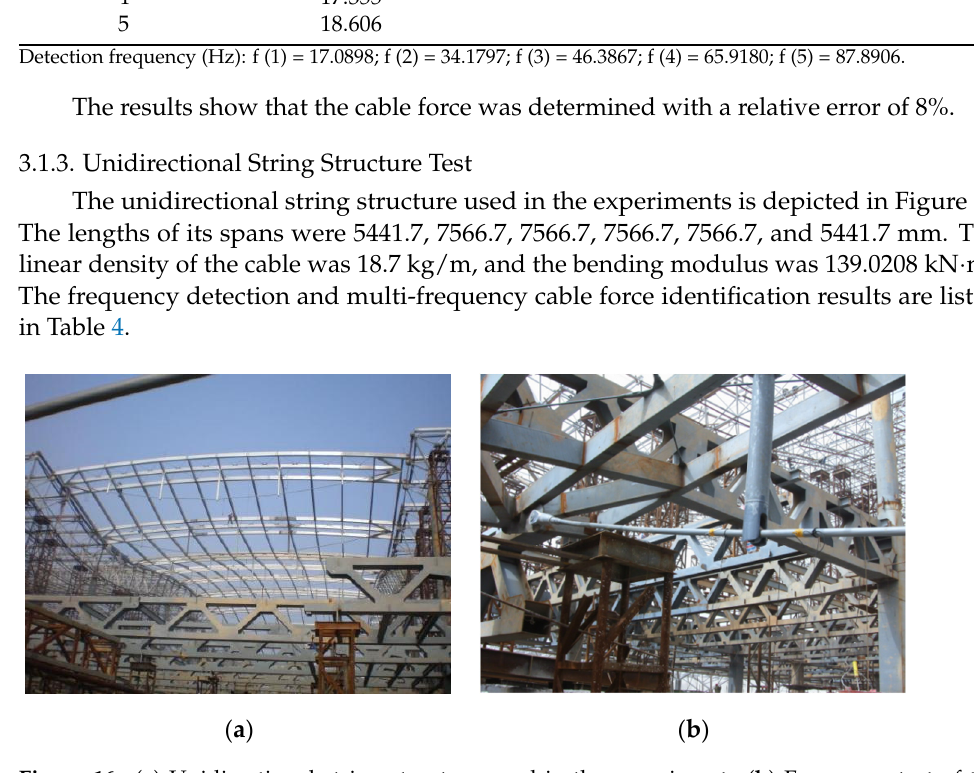
Figure 16. ( a ) Unidirectional string structure used in the experiment. ( b ) Frequency test of the unidirectional string structure. Table 4. Results of frequency detection and multi-frequency fitting cable force optimization of a unidirectional string structure.